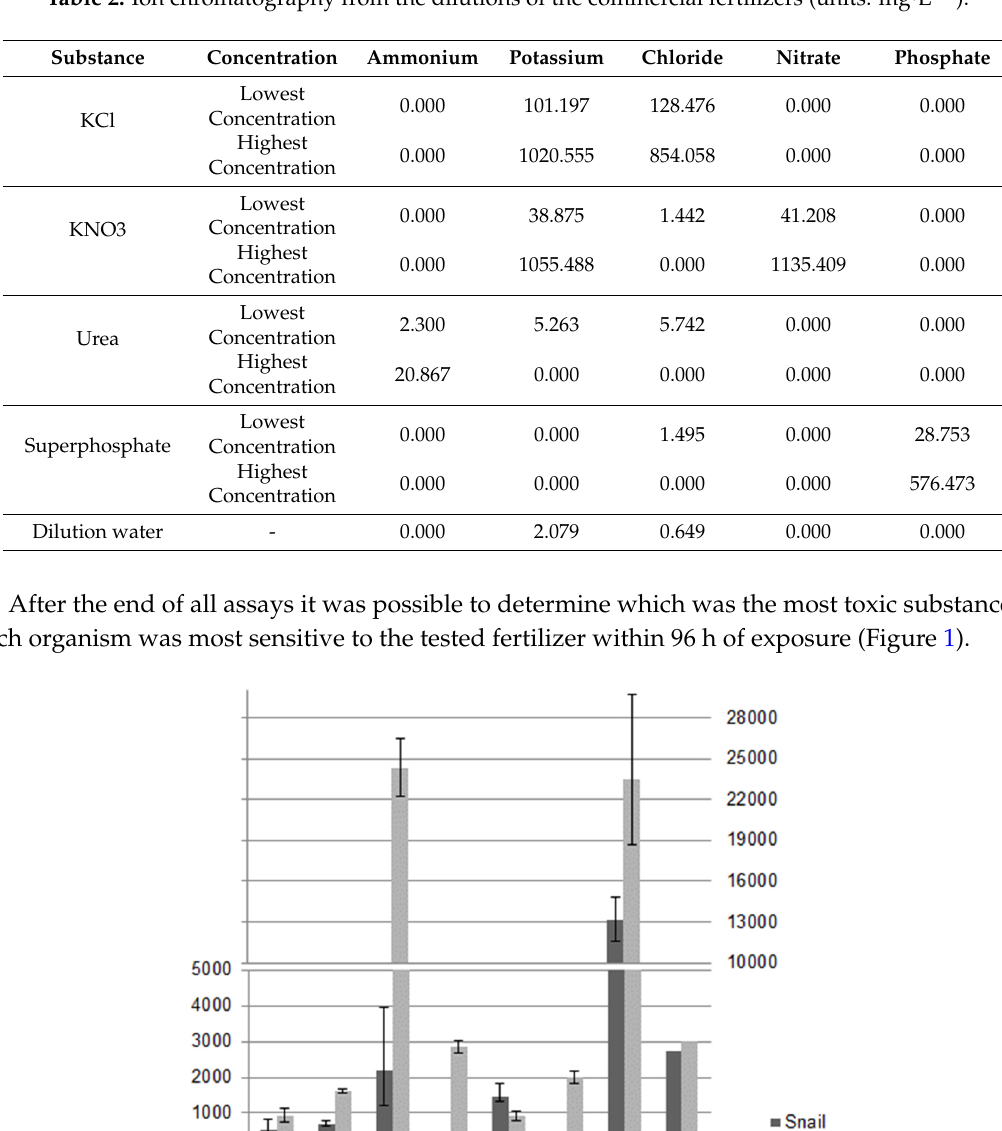
Table 2. Ion chromatography from the dilutions of the commercial fertilizers (units: mg · L − 1 ).